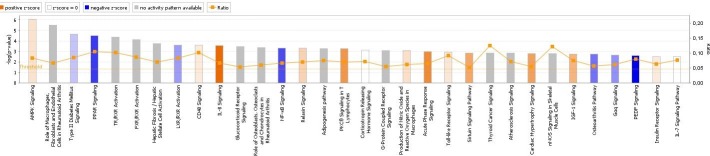
Top canonical pathways (p < 0.005) identified by functional analysis of DE genes in crossbred fetuses (orange bars) and Iberian fetuses (blue bars).